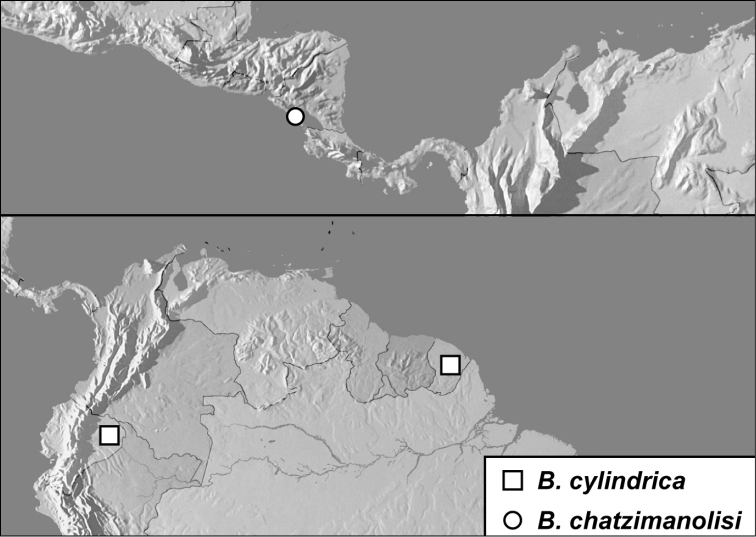
Baconia cylindrica group records.